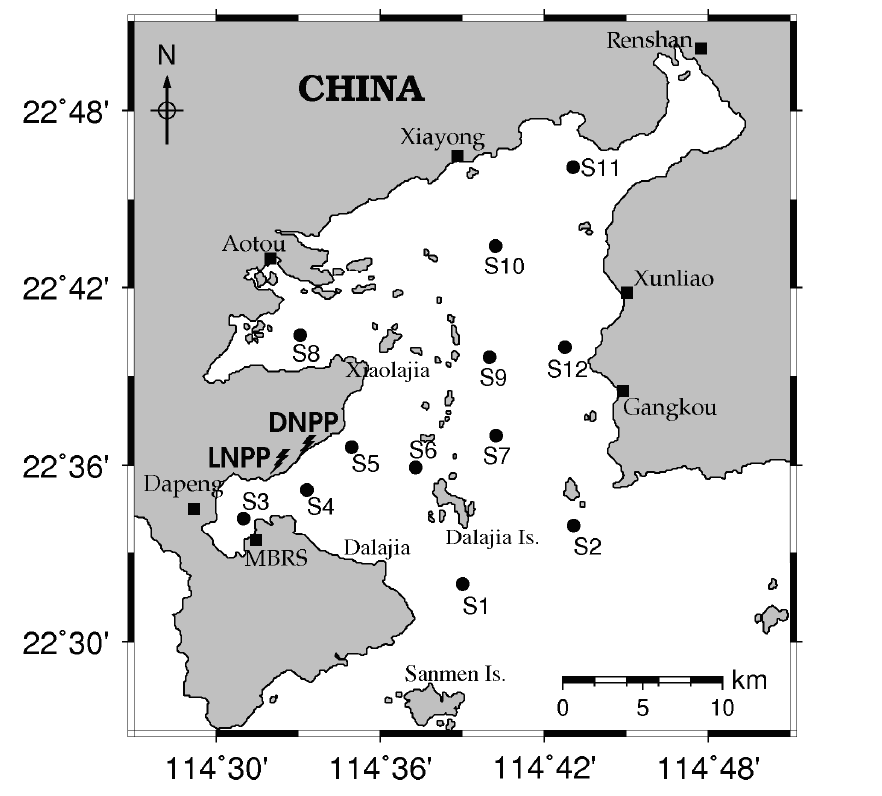
Figure 1. Sampling stations in Daya Bay (Adapted from